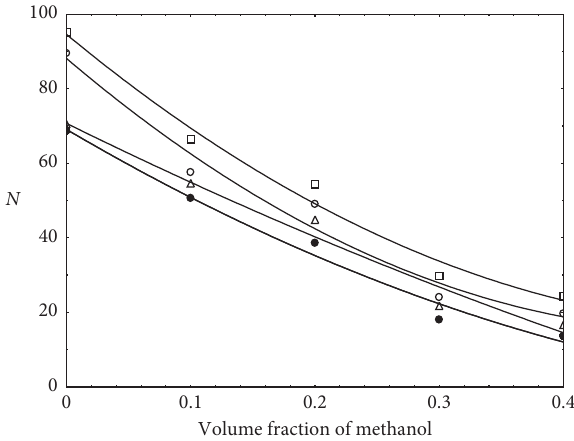
Figure 11: Variation in N CTAB with the volume fraction of methanol: triangles (298.15K), circles (308.15K), squares (318.15K), and circles (323.15